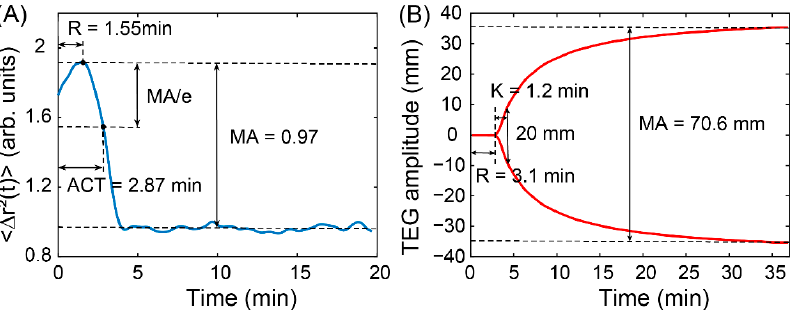
Figure 3. Coagulation time curves of the same sample measured by the OVM and TEG. ( A ) Coagulation trace of MSD over clotting time at a lag time of 0.02 s. ( B ) Corresponding coagulation profile measured by TEG. Differences in coagulation parameters result from different methods.